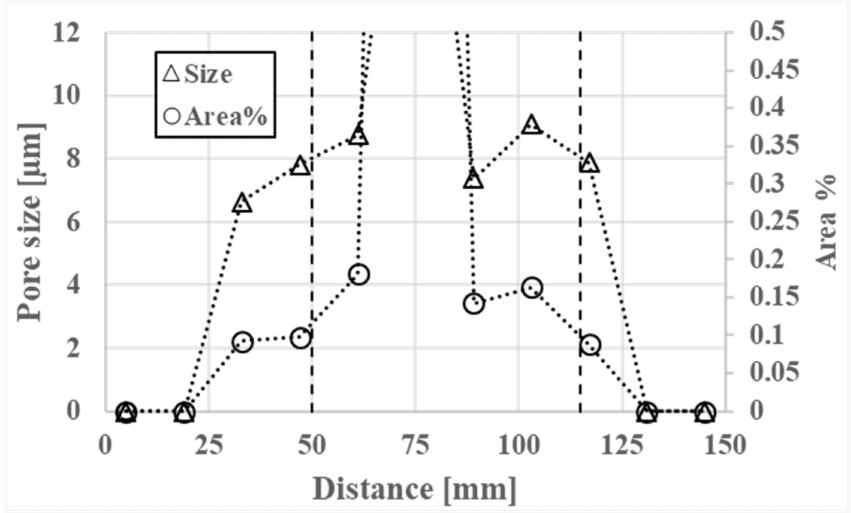
Figure 9. Average size and area% of analyzed porosity from the billet cross section. The horizontal lines show the width of the equiaxed